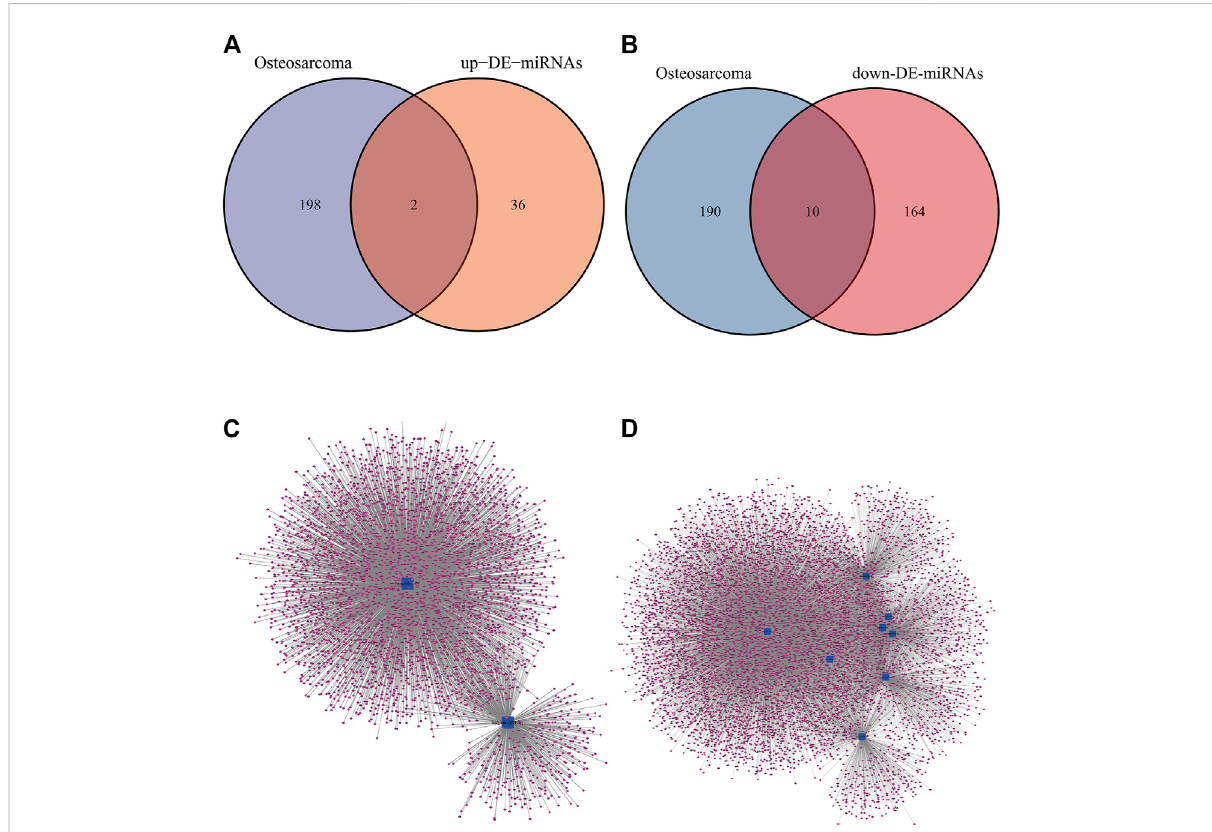
FIGURE 2 DE-miRNAs predicted potential target mRNAs in miRNet database. (A) The Venn diagram for the overlapping up-DE-miRNAs. (B) The Venn diagram for the overlapping down-DE-miRNAs. (C) The miRNA – mRNA networks of all up-regulated mRNAs. (D) The miRNA – mRNA networks of all down-regulated